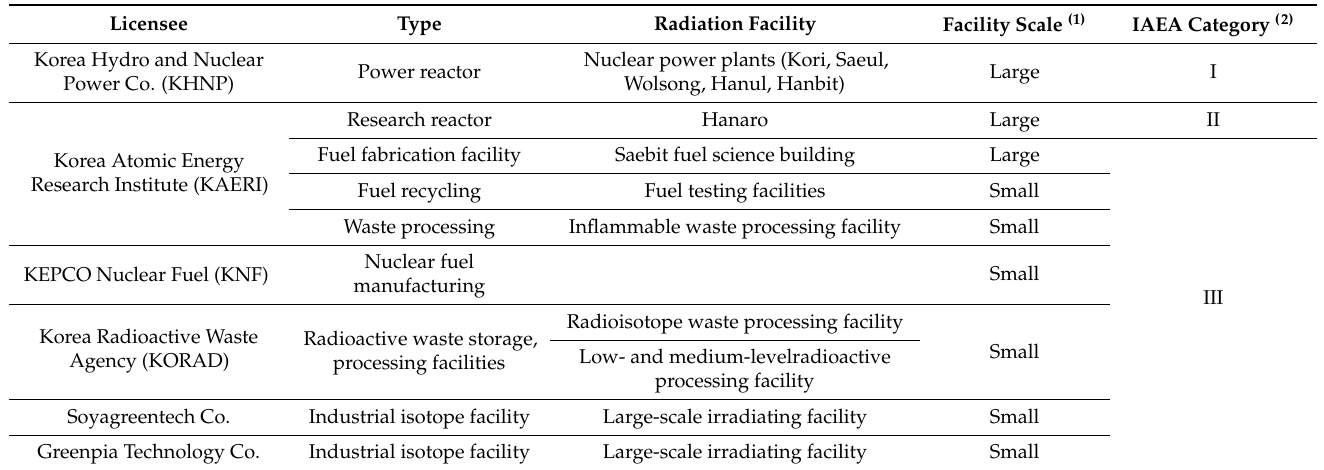
Table 1. Radiation facilities in Korea (June 2021).